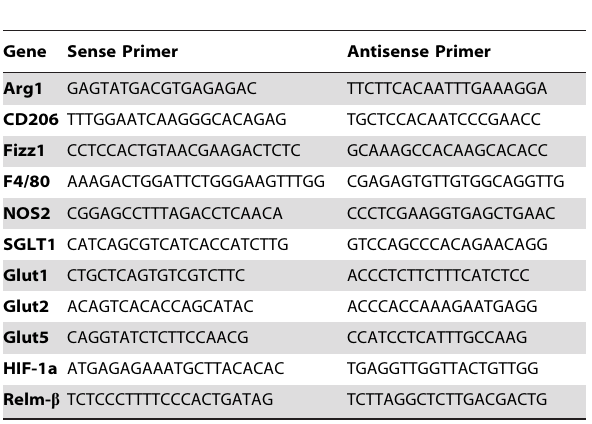
Table 1. Sequences of the sense and antisense primers used for quantitative real time RT-PCR.